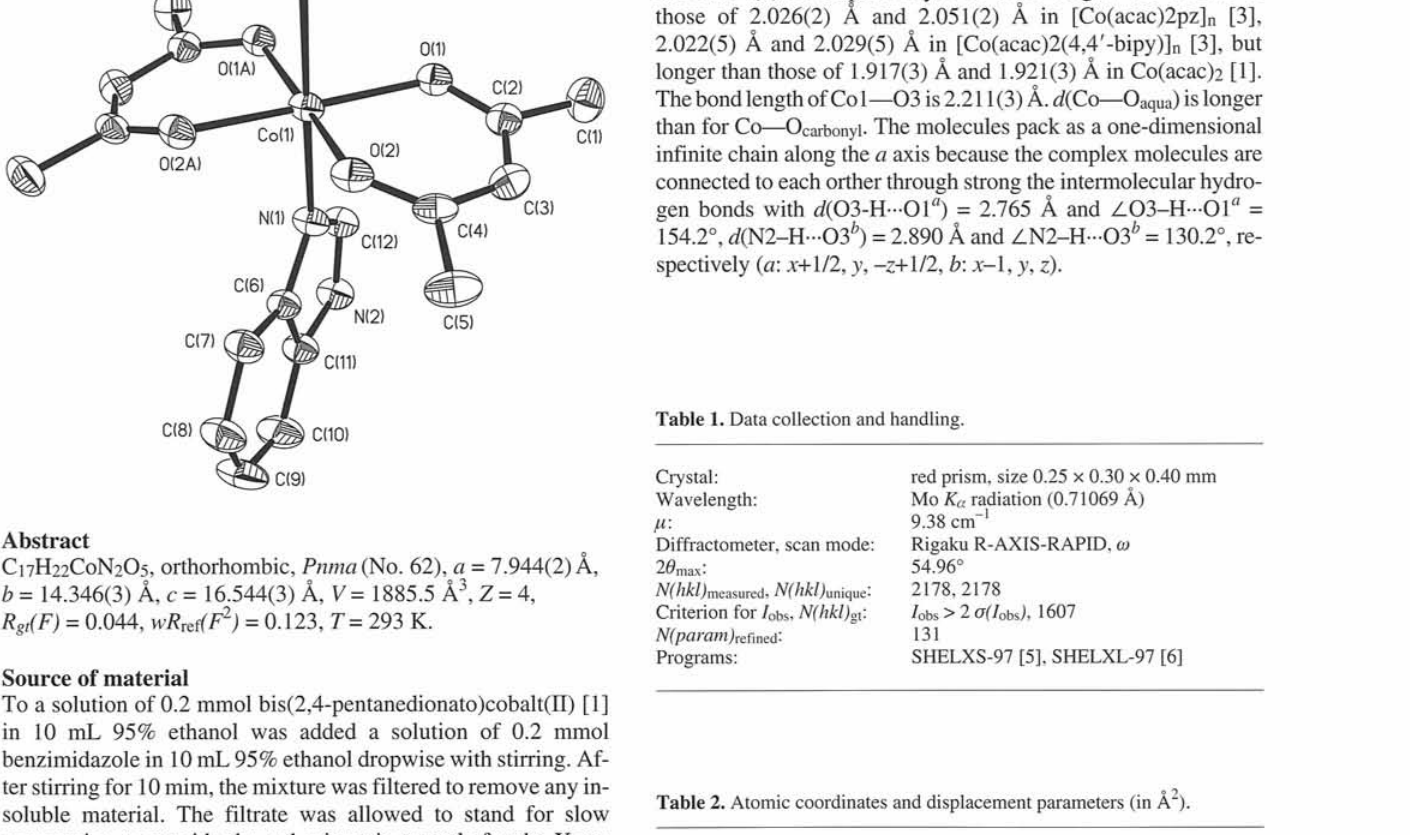
Table 2. Atomic coordinates and displacement parameters (in